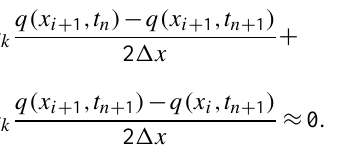
Fig. 2. Grid element for the discretisation of the KW equation and the routing